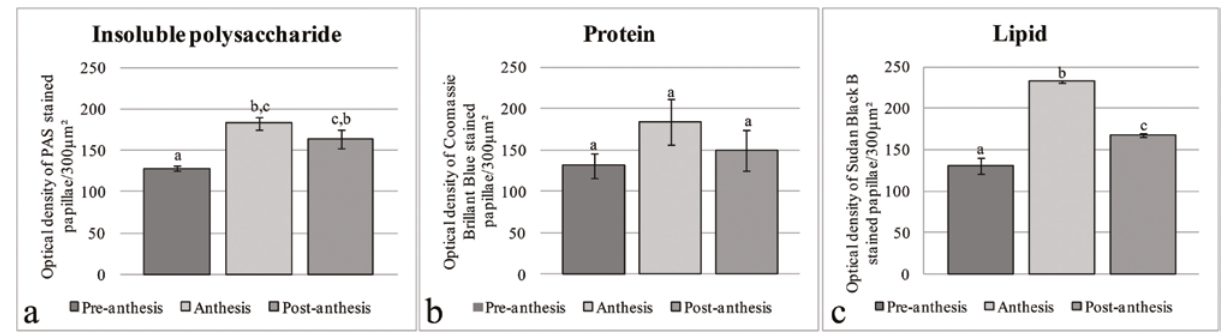
Figure 3. Organic material dynamics of papillae cells during stigma development of Hibiscus syriacus . a. Insoluble polysaccharide content, b. Protein content, c. Lipid content. Data are expressed as optical density per area unit (300 µm²). The data with different letters are signifi- cantly different according to Tukey’s test at P < 0.05 for independent samples. Results are expressed as mean ± SD.